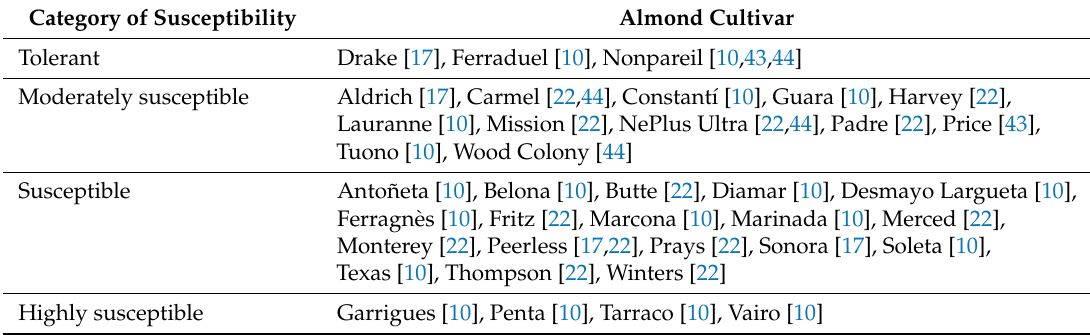
Table 1. Grouping of commercial almond cultivars on the basis of their susceptibility to anthracnose caused by Colletotrichum spp.